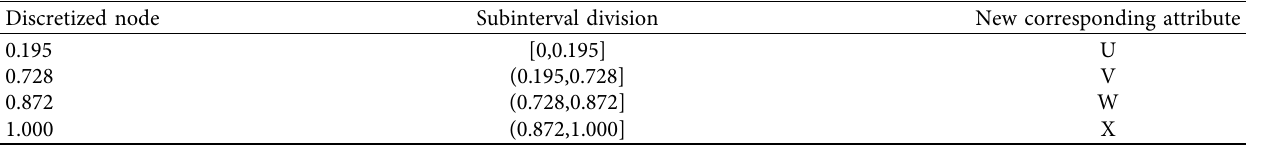
Table 1: Data discretization